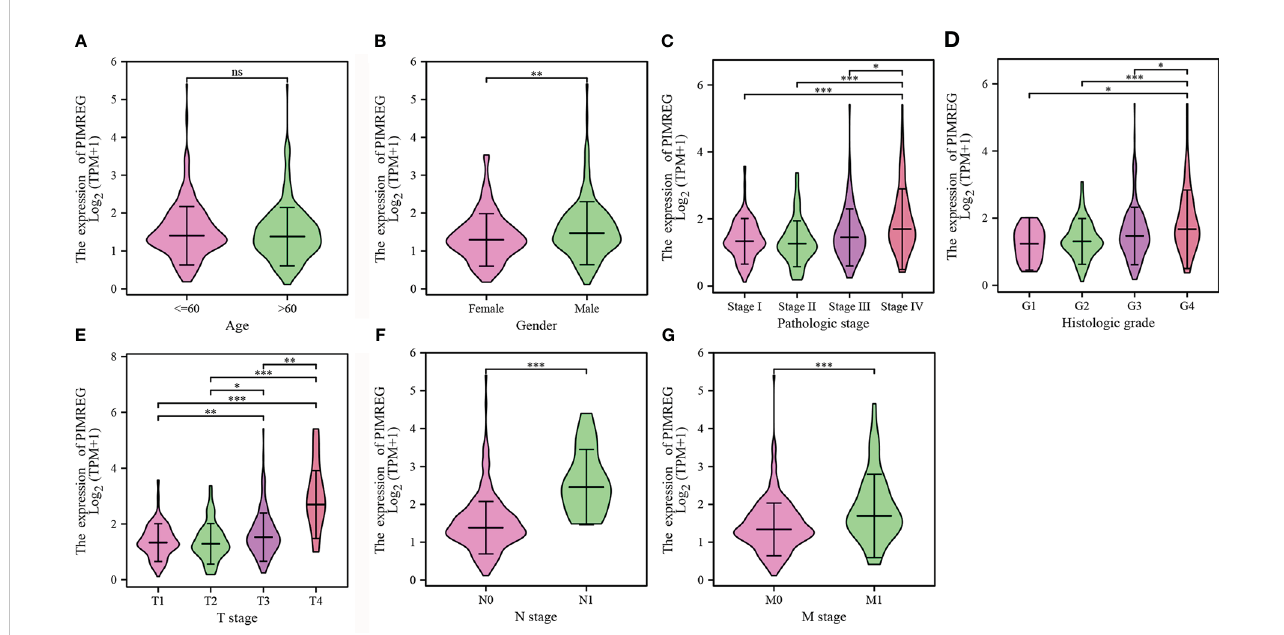
FIGURE 2 Associations between the PIMREG expression levels and clinical characteristics. (A) age; (B) gender; (C) pathologic stage; (D) histologic grade; (E) T stage; (F) N stage; (G) M stage. *P < 0.05, **P < 0.01, ***P < 0.001, ns: no signi fi